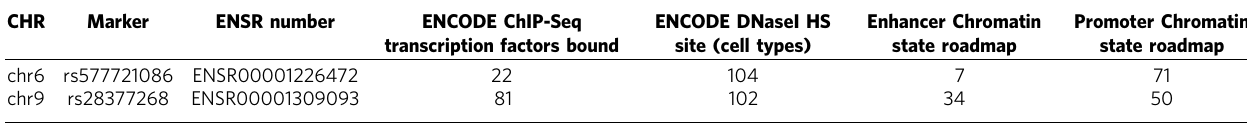
Table 1 | Overlap of rs28377268 at the 9q22.23— PTCH1 locus and rs577721086 at the 6q22.33 RSPO3 locus with potential regulatory regions.